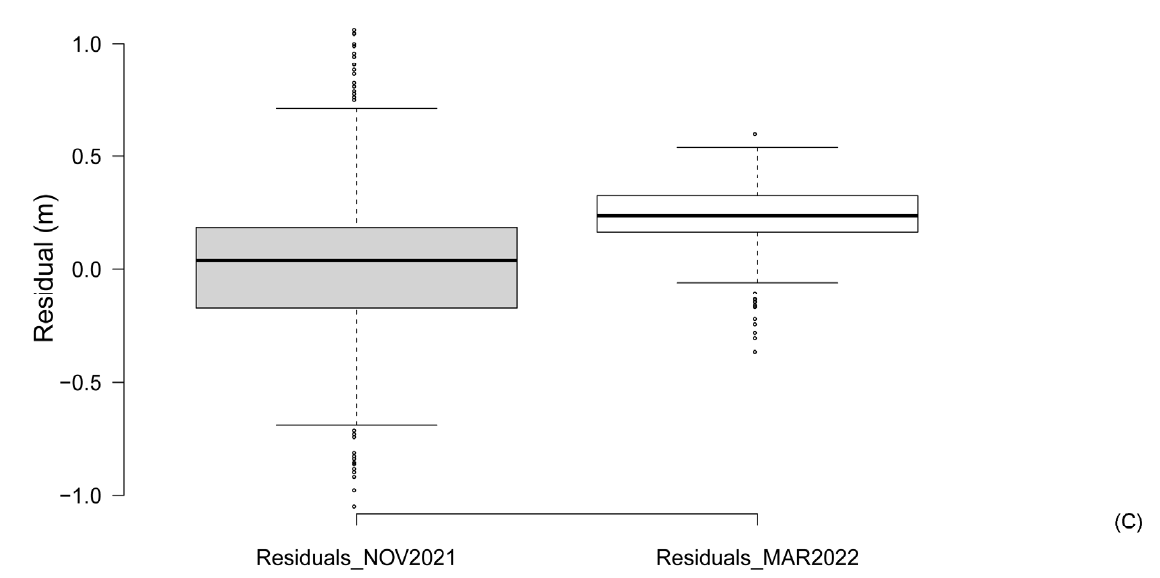
Figure 4. Absolute residual values over bathymetry map for: ( A ) November 2021 bathymetry inversion; ( B ) March 2022 bathymetry inversion; ( C ) Box-plots of residual values for each date. The black horizontal line inside each box indicates the median value of each sample and the whiskers extend from the 1st to the 3rd